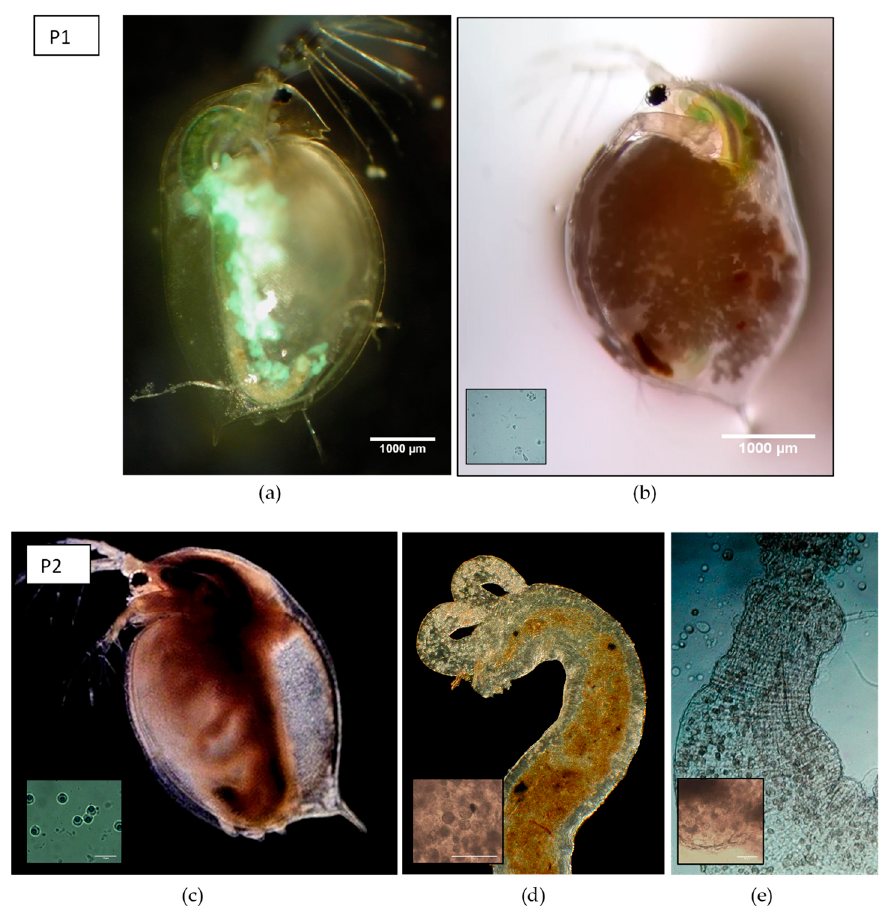
donor populations received a parasite treatment (P1, P2, PC), after which the donor microbial inocula were obtained (M1, M2, MC) for the transplant experiment ( right panel ). P1 consisted of a pool of White Fat Cell Disease (WFCD) and Binu- cleata daphniae. P2 consisted of a pool of Pasteuria ramosa, Ordospora colligata and Mitosporidium daphniae. PC is the control treatment and consisted of a pool of healthy squashed Daphnia individuals. In the transplant experiment ( right panel ), sterile recipient individuals of three Daphnia genotypes (KNO, OM2, T8) were exposed to the donor microbiomes obtained from the adaptation experiment (M1, M2, or MC). Each of these microbiome treatments were crossed with the three par- asite treatments (P1, P2, or PC; similar as in the microbiome adaptation experiment).